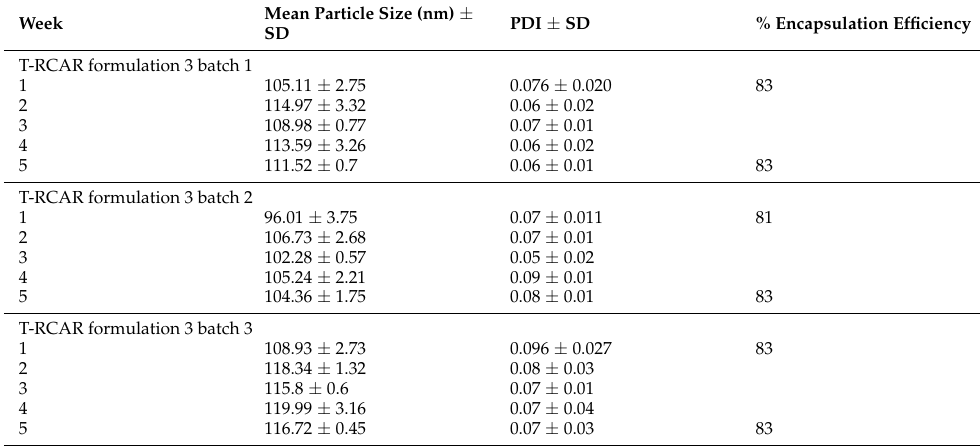
Table 3. Stability data for T-RCAR formulation 3 (T-RCAR-3). Week